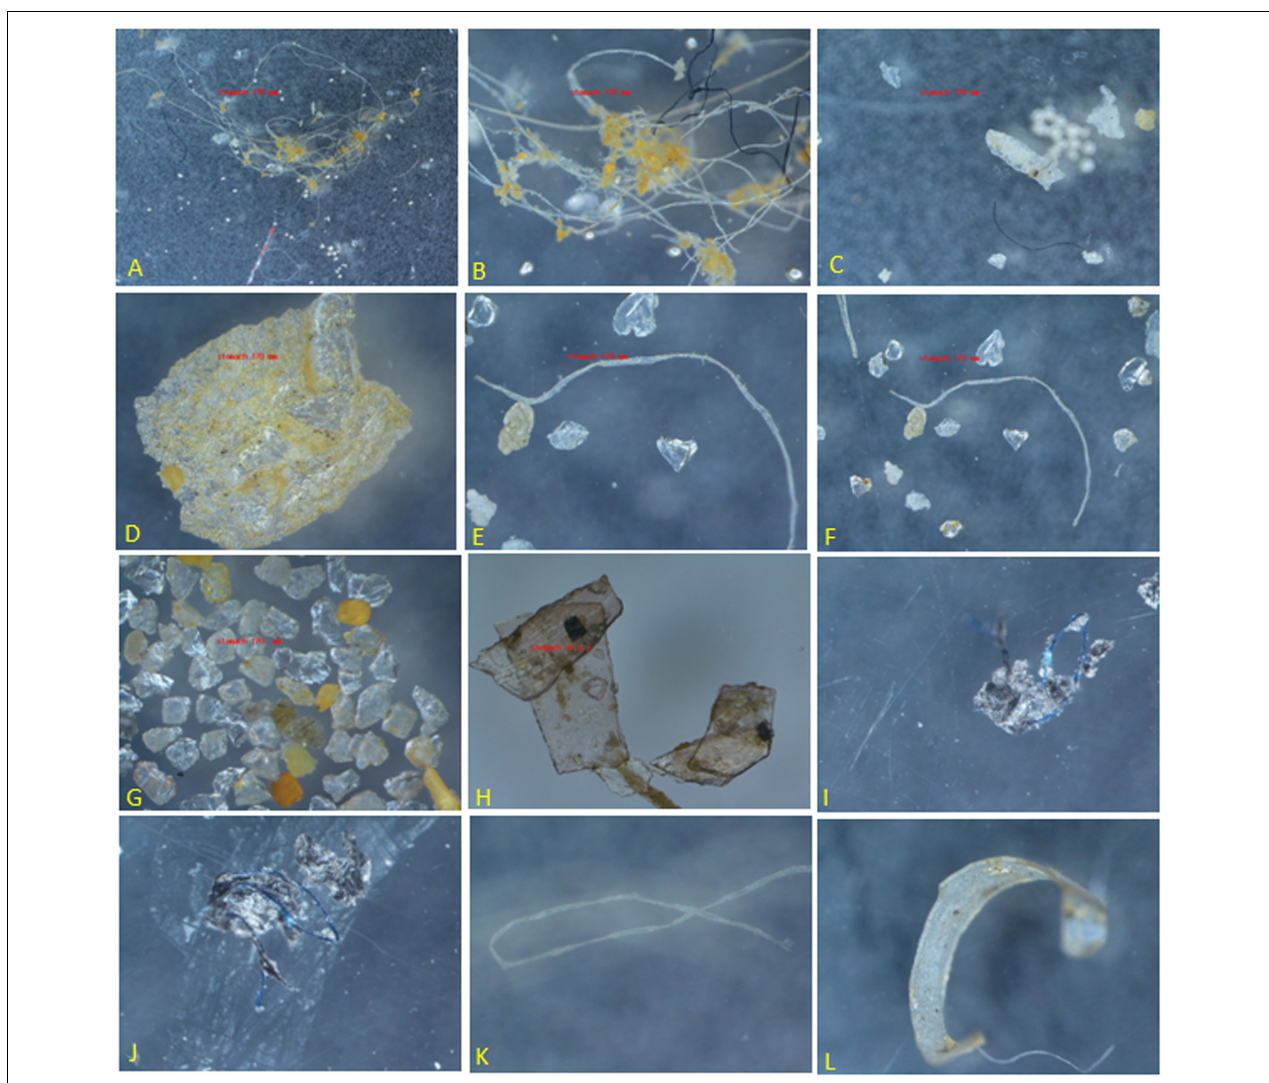
FIGURE 1 | Photomicrograph (170, 120, 100 µ m) showing different shapes, sizes, and colors of microplastic (A–L) retrieved from the fishes and crabs inhabiting the waters around Karachi city (AG is beads; BEFKL fibers; CEFGIJ films; D foam and H is fragment). TABLE 1 | Summary of the morphometric characters, lengths, weights, feeding habits, and habitat of four species used to evaluate MPs in gastrointestinal tracts ( N , number of specimens; TL, total length; TW, total weight; R 2 , coefficient of determination; SE, standard error; MF, minimization failure). TLcm TWgm Stomach Intestine